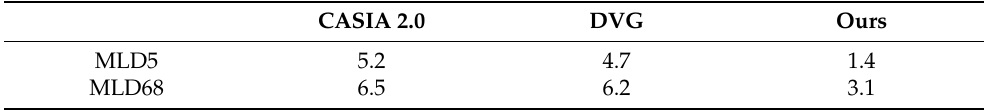
Table 1. Comparisons of mean landmark distance (MLD) with the CASIA NIR-VIS 2.0 dataset, DVG and our results. Lower values are better.